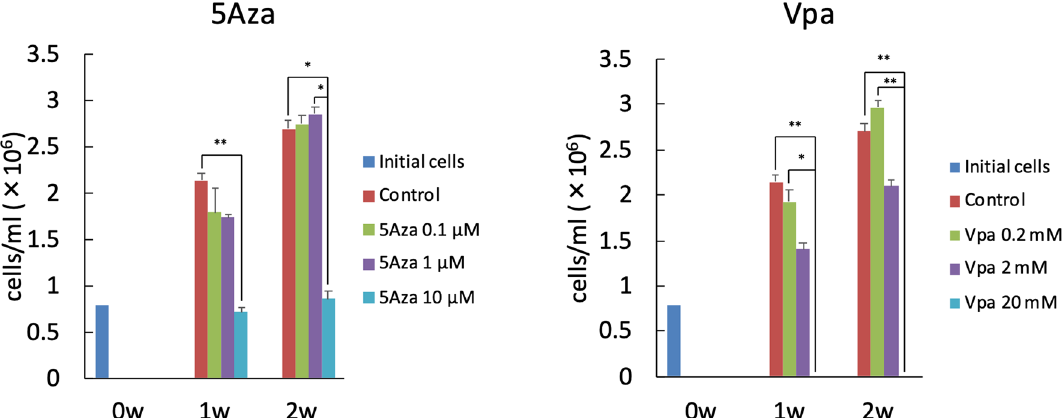
Figure 2. Cell viability. The ERM was cultured at a cell density of 0.8 × 10 6 cells/ml (initial cells) in ESCM